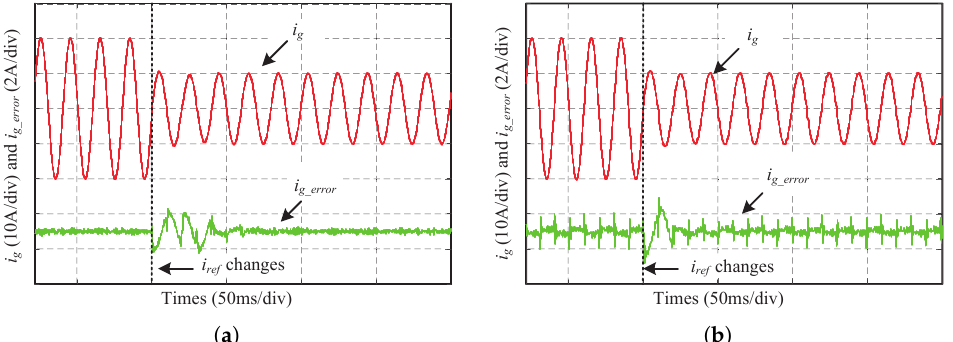
Figure 21. Transient waveforms and current errors of different control systems when reference current changes, with grid frequency f g = 50.4 Hz. ( a ) FA-IRC system. ( b ) PIMR-RC